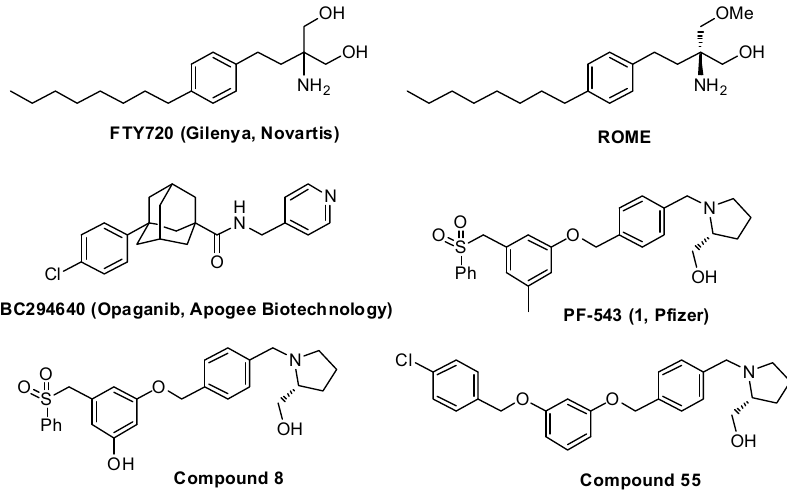
Figure 1. Known sphingosine kinase inhibitors and FTY720.